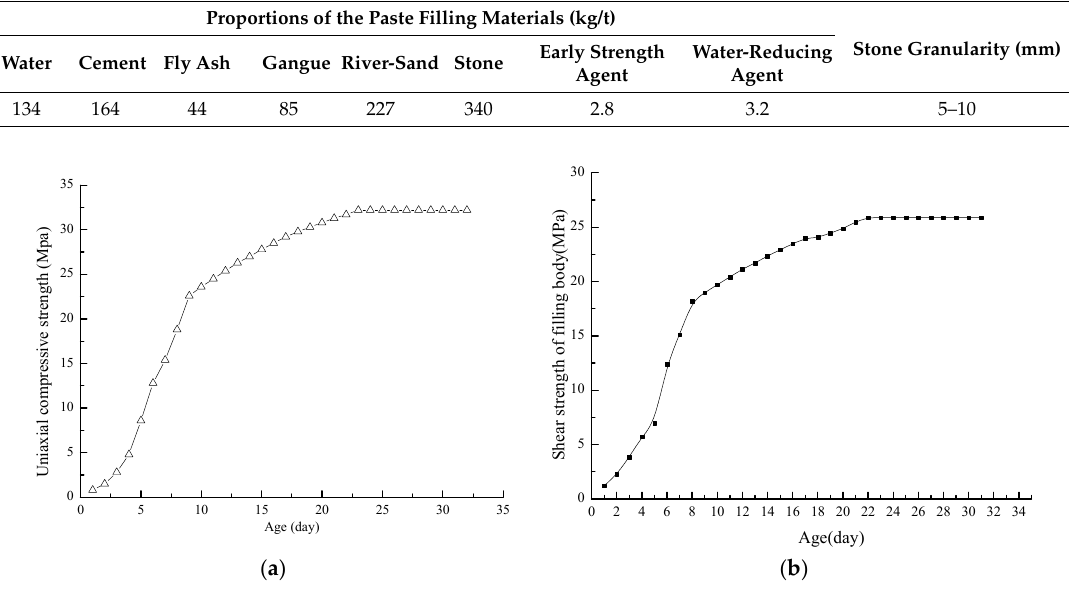
Figure 2. Relationships between strengths and curing time of cement-based filling body: ( a ) relationship between uniaxial compressive strength and age and ( b ) relationship between shear strength and age.